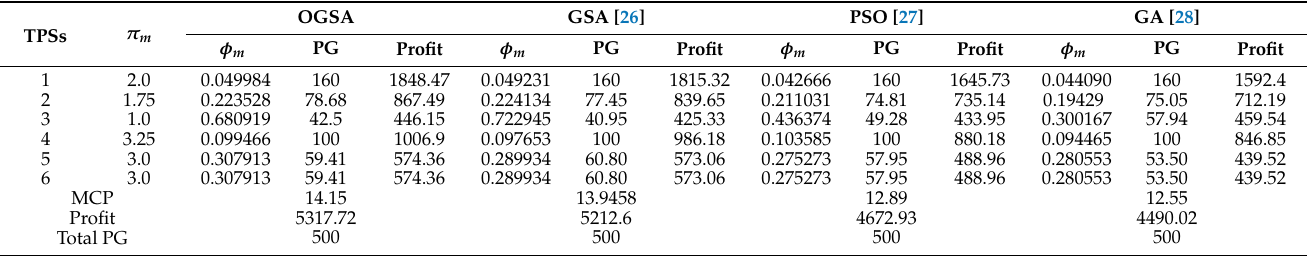
Table 4. Findings for the IEEE standard 30-bus exclusive of renewable influence.